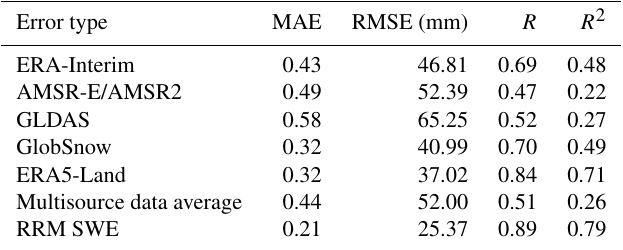
Table 2. Error list for the station data and grid snow water equiva- lent products.